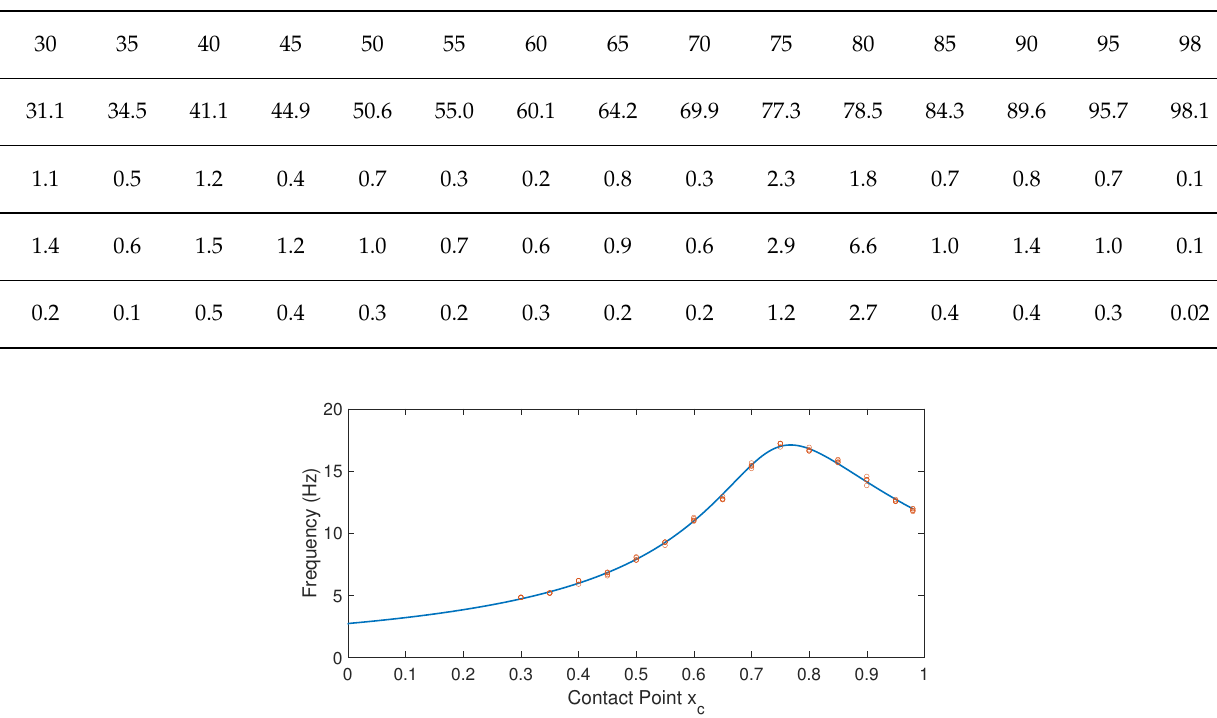
Table 4. Experimental results obtained for the estimation of the contact point for Case 2.